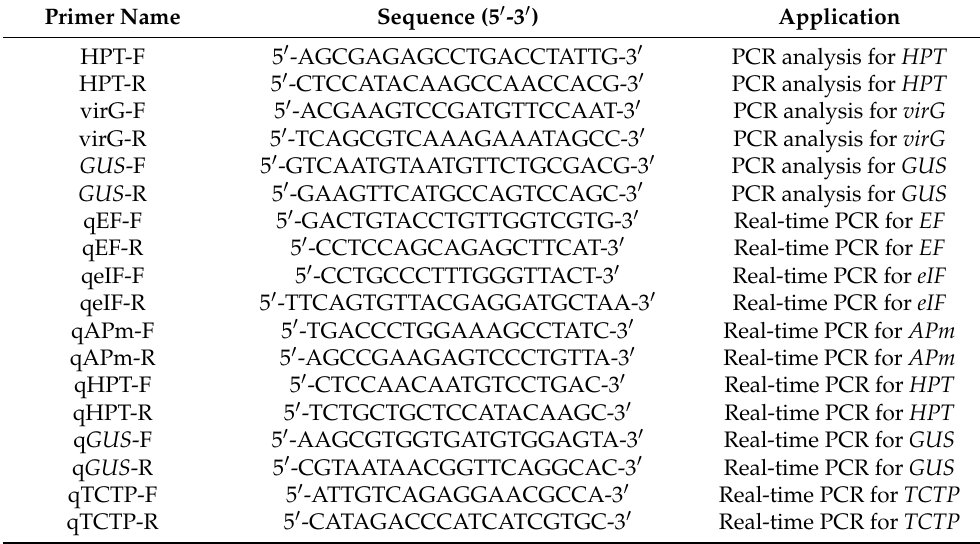
Table 1. Oligonucleotide primers used in the